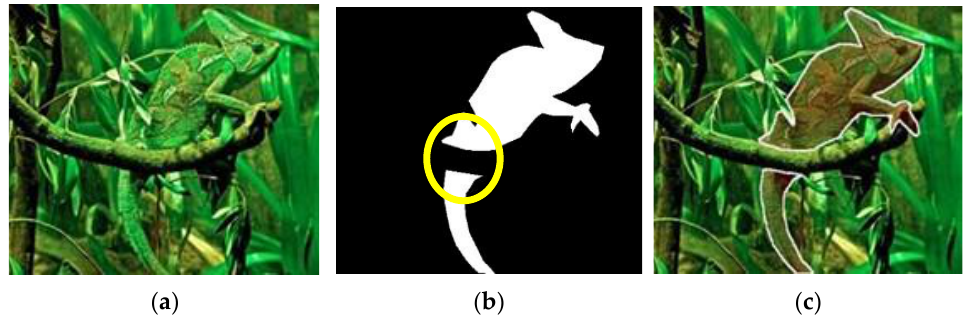
Figure 2. Occlusion in camouflage objects: ( a ) original image (The circle shows that the particular object sitting on the branch has occlusion); ( b ) ground truth label; ( c ) overlaid.